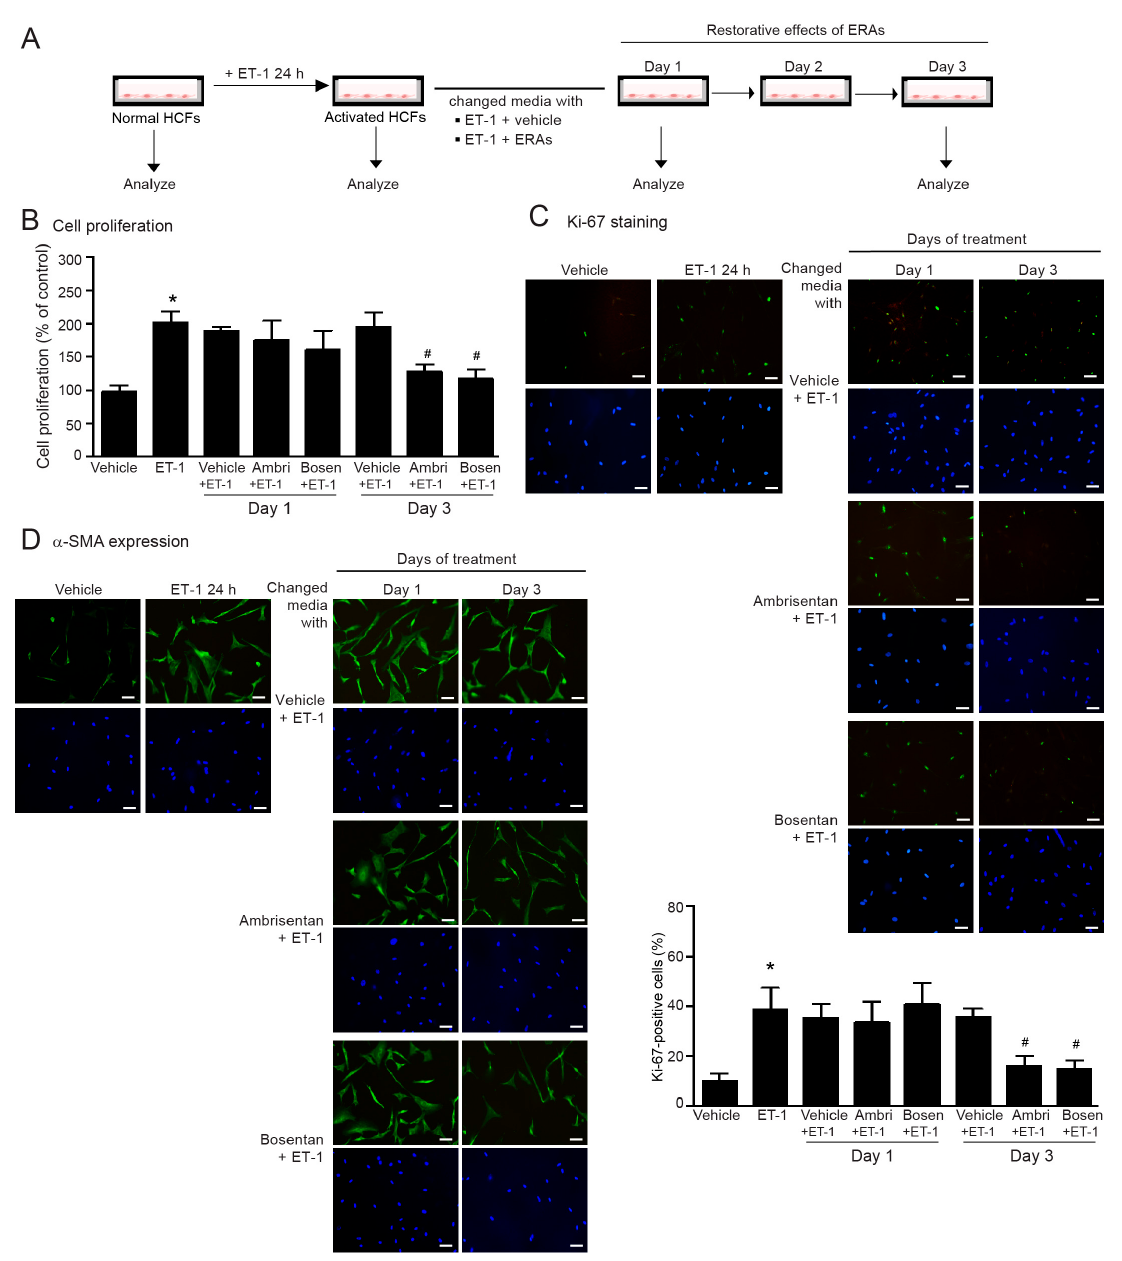
Figure 6. Restorative effects of ERAs on ET-1-induced cell proliferation and α -SMA synthesis. ( A ) Schematic diagram representing timeline of cell culture and treatment. ( B – D ) Cells were treated with 20 nM ET-1 for 24 to induce myofibroblast differentiation. After treatment for 24 h, the media were changed to either ET-1 plus vehicle, ET-1 plus ambrisentan, or ET-1 plus bosentan. Cells were further cultured for 3 days. The analysis of cell proliferation and α -SMA expression was taken on day 1 or 3 after co-treatment. ( B ) Cell proliferation was calculated as the percentage relative to the control group. ( C ) Cells were stained for Ki-67 (green) and nucleus DAPI (blue). Scale bar, 10 µ m. Proliferative capacity was calculated as the percentage of Ki-67-positive cells. ( D ) α -SMA protein expression was visualized by fluorescent microscope. Cells were stained for α -SMA (green) and nucleus DAPI (blue). Scale bar, 10 µ m. Data were expressed as the mean ± SD. ( n = 4). * p < 0.05 vs. vehicle; # p < 0.05 vs.